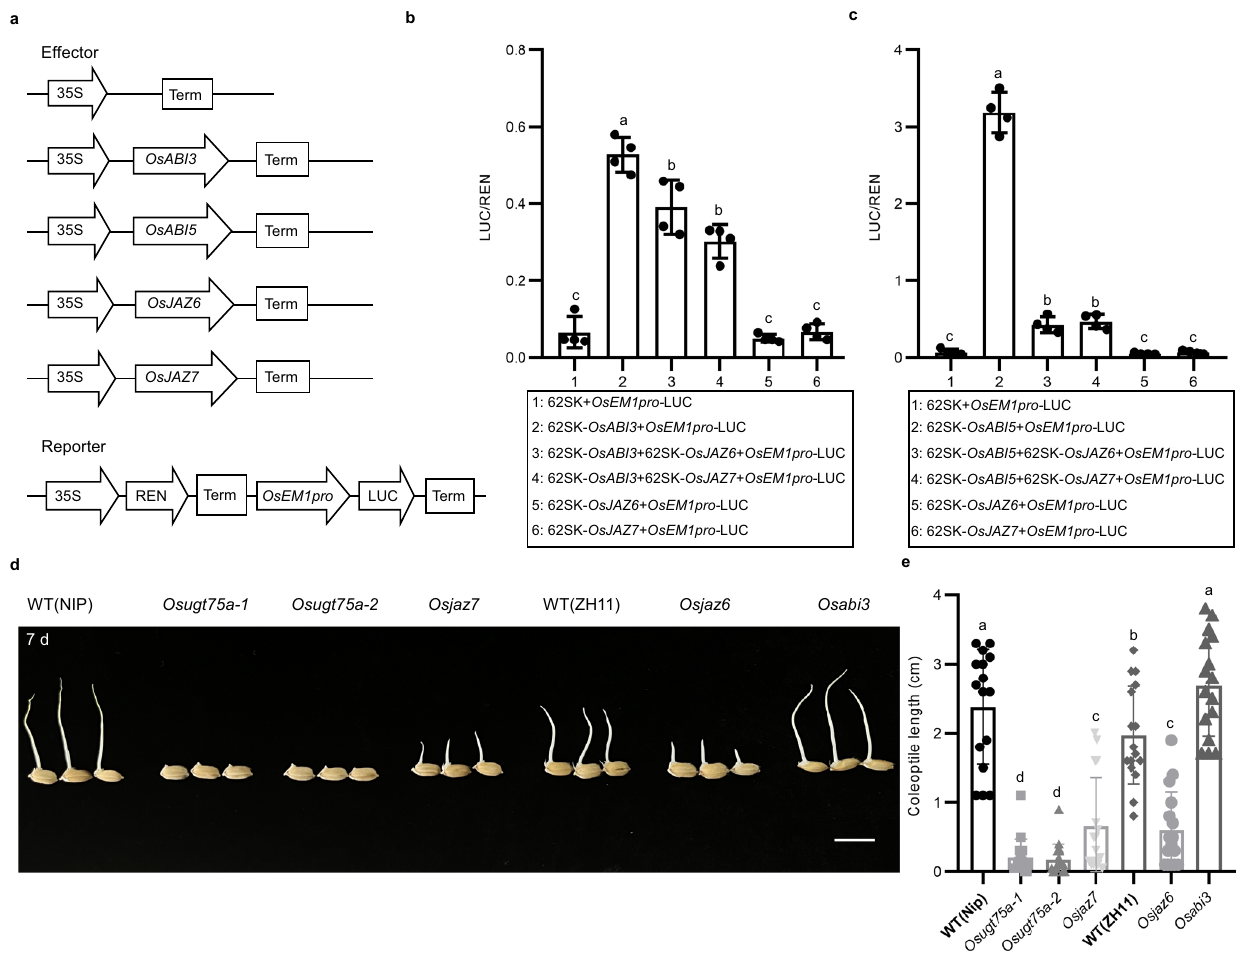
Fig. 6 | OsUGT75A regulates coleoptile length involving the ABA and JA sig- naling pathways. a Schematic diagrams of the reporters and effectors used in transienttransactivationassays. b , c Transientdual-luciferase(LUC)reporterassays revealed that the OsABI3/5 activation of ABA response gene ( OsEM1 ) expression could be repressed by OsJAZ6/7. Data were presented as mean±SD, n =4 biolo- gicallyindependent experiments. d Representative images of the coleoptile length